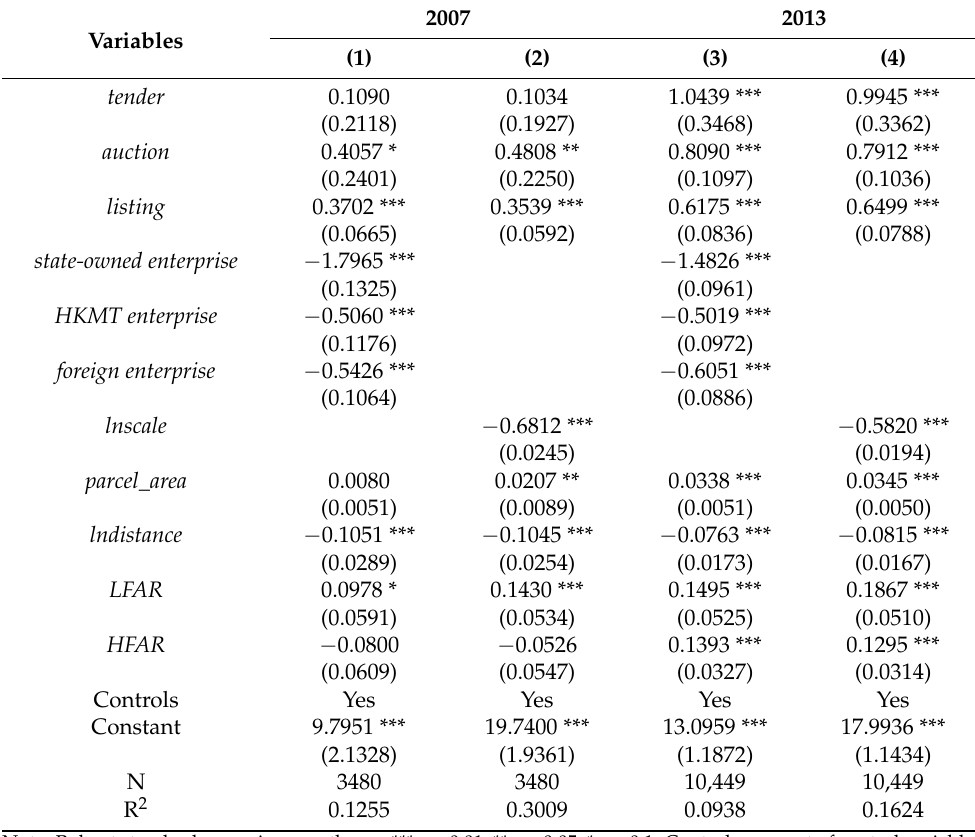
Table 8. Influence of industrial land transfer modes on enterprises’ willingness to